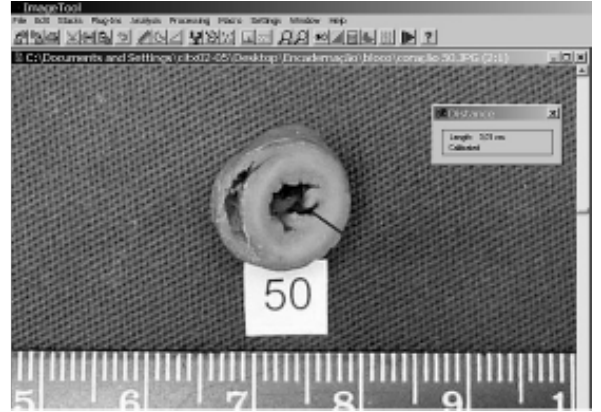
Fig. 2 – Representação da mensuração da espessura da parede do ventrículo esquerdo, utilizando-se o software Image Too